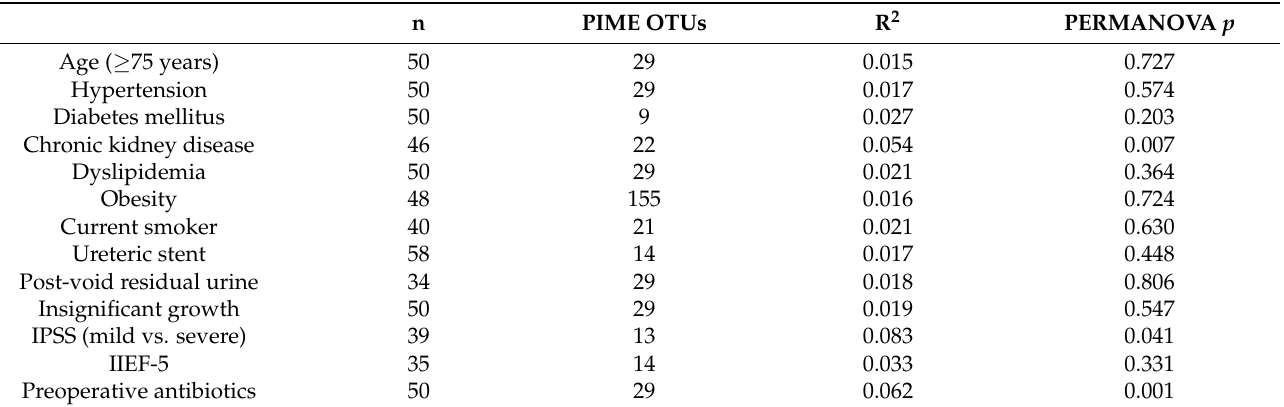
Table 3. Summary of beta diversity analyses. Notably, there was a significant difference in microbiome composition between patients with CKD versus no CKD ( p = 0.007), mild versus severe LUTS assessed by IPSS ( p = 0.041) and between those who were administered single-dose antibiotics versus those with no prophylaxis ( p = 0.001) (Figure